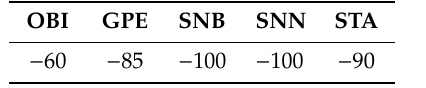
Table 7. Angles used for rotation of angular wind direction at di ff erent sites.